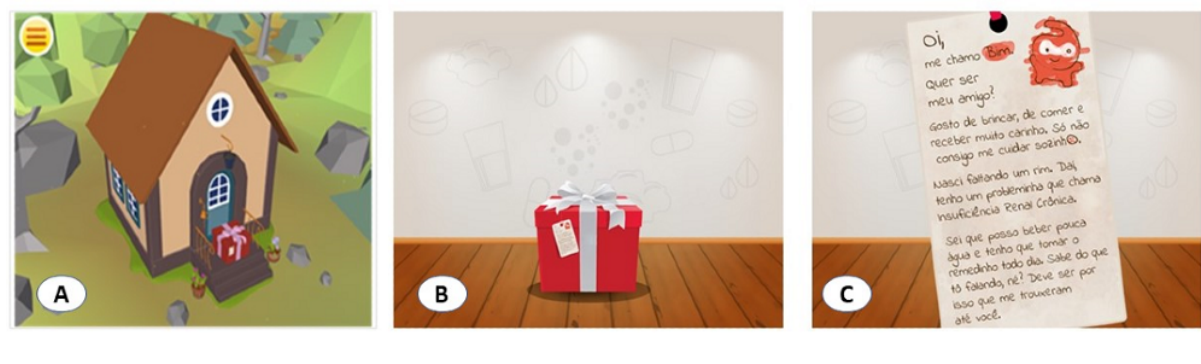
Figure 2. The initial app design. A: home scenario; B: gift box; C: presentation